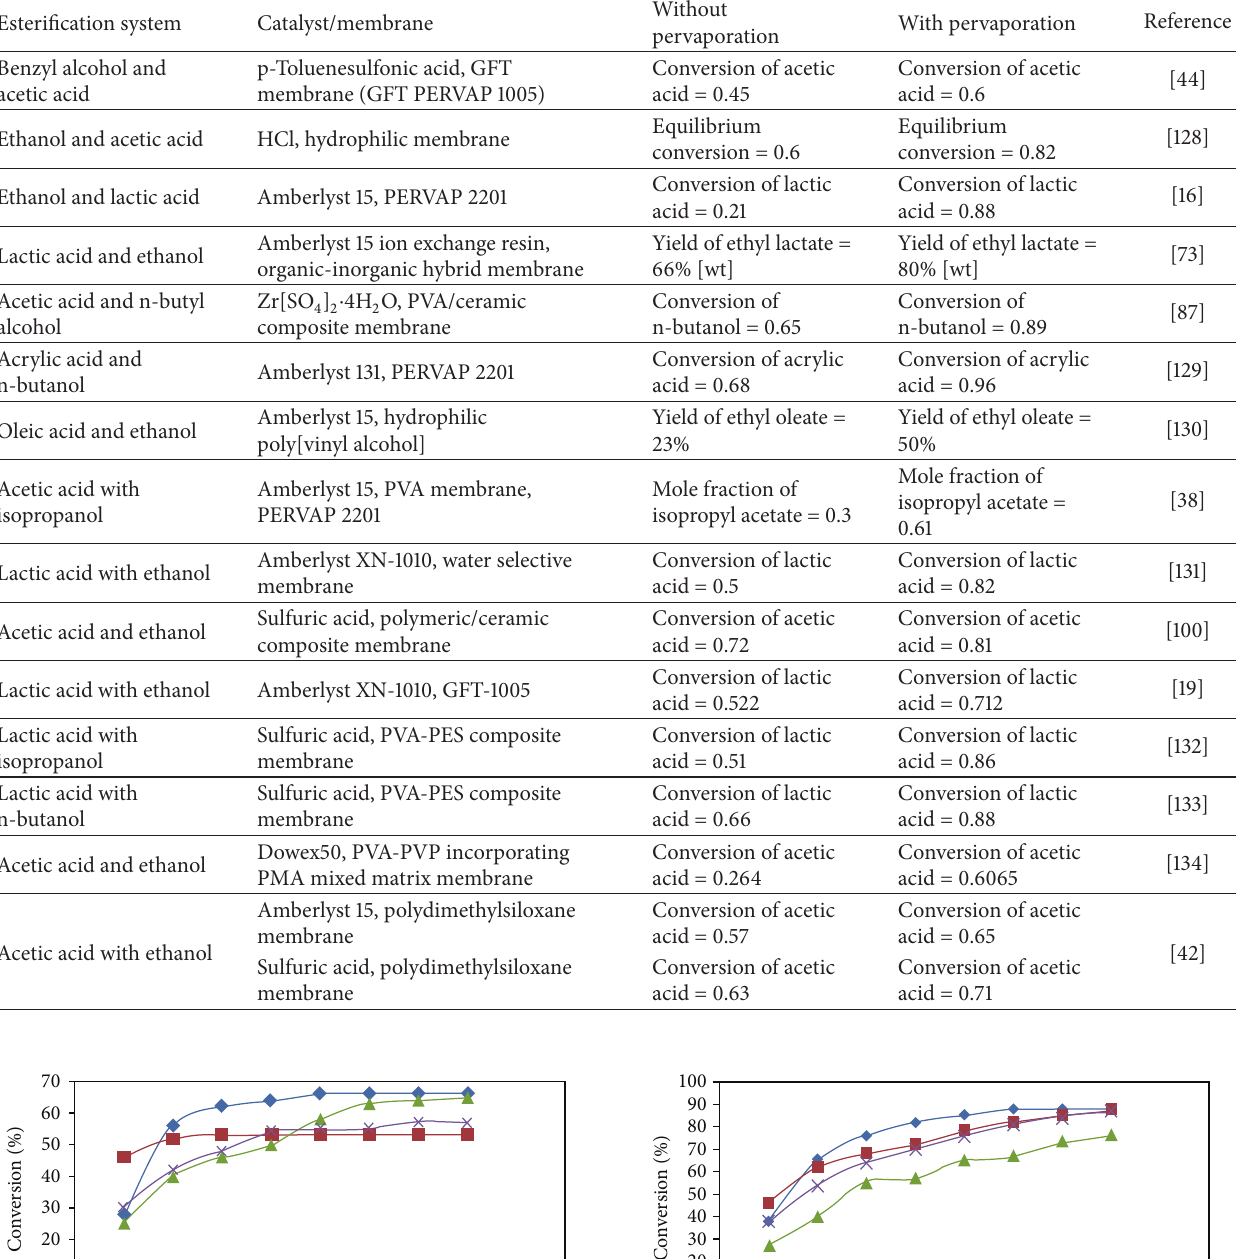
Table 3: Comparison of results of esterification reaction with and without pervaporation.